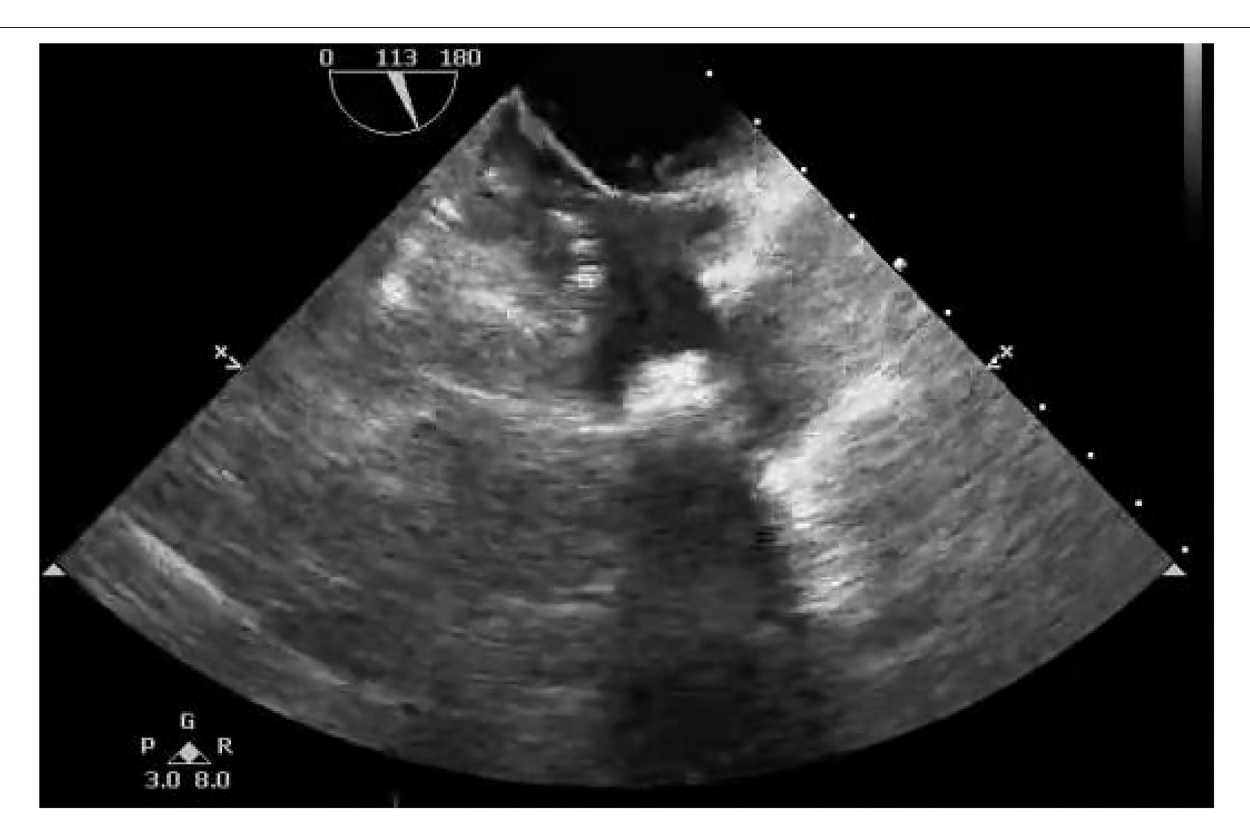
were detected. The patient was eventually diagnosed with a ASD (occluder